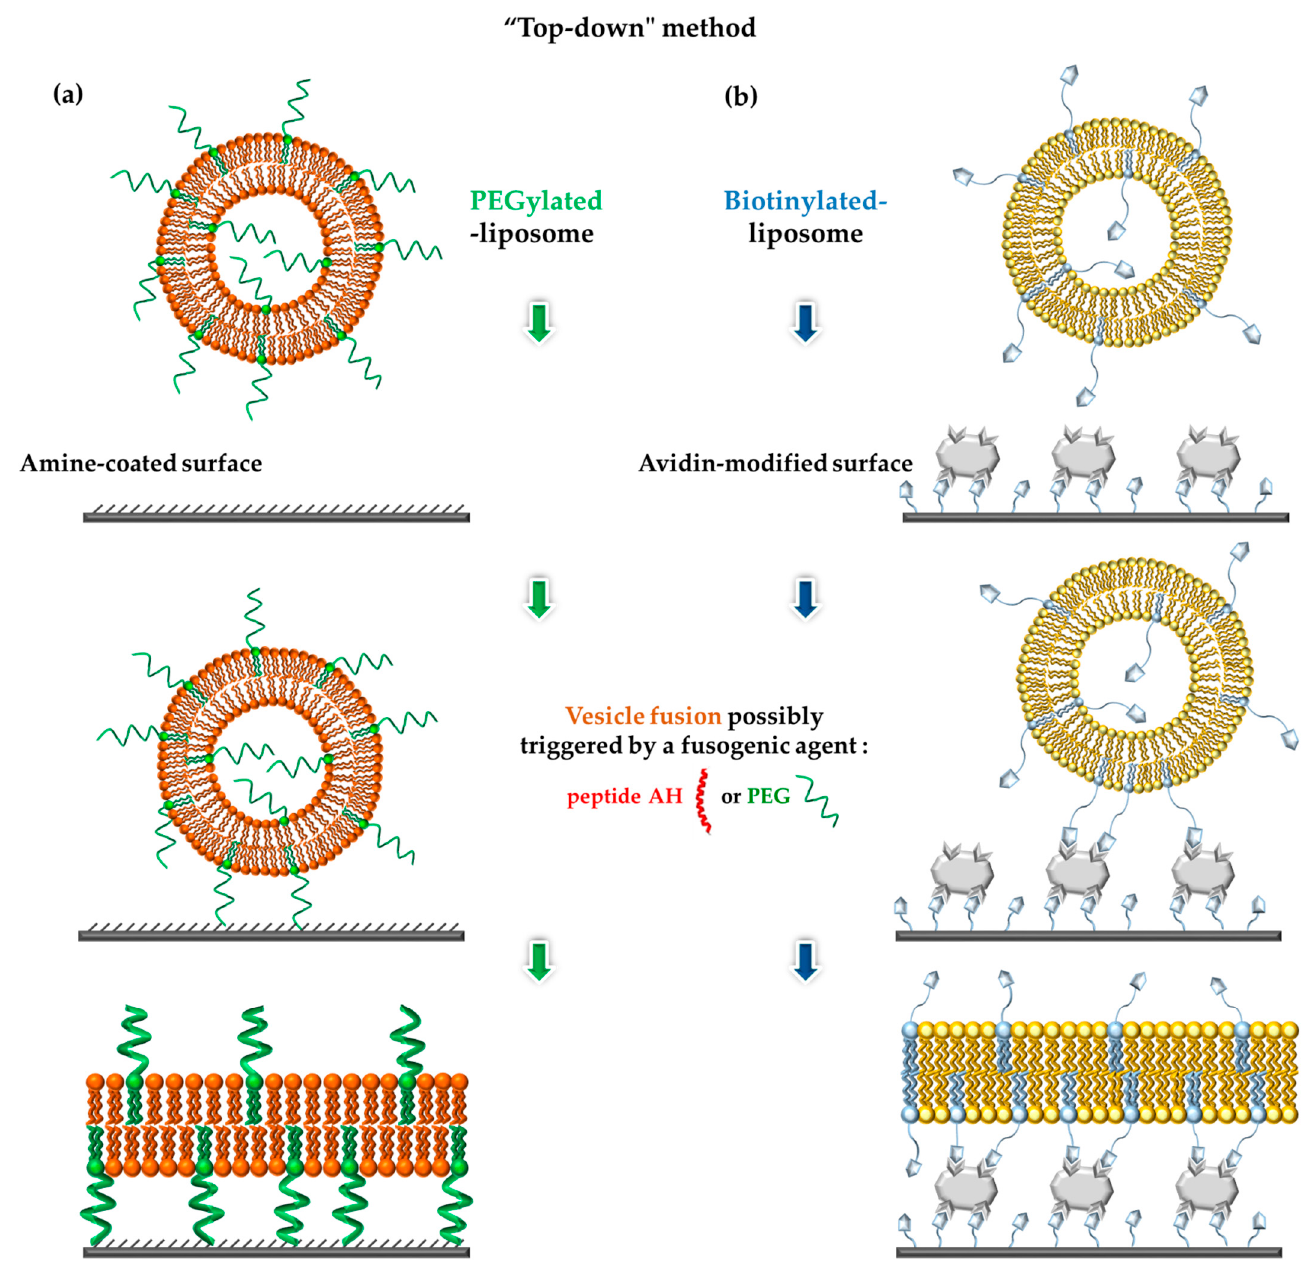
Figure 2. tBLMs formed by fusion of lipid vesicles containing both the anchor and the spacer molecules on a functionalized surface via a “top-down” approach. ( a ) using PEG as spacers, by fusion of liposomes containing either DSPE-PEG-NHS or DSPE-PEG-PDP on an amine-coated surface; ( b ) using biotin/avidine as spacers, by fusion of biotinylated vesicles on a sublayer of immobilized streptavidin. In both cases, the liposome fusion can be triggered by a fusogenic agent (i.e., PEG- 8000 solution [81,134,214,217] or an amphipathic α -helix (AH) peptide [39] ). DSPE-PEG-NHS: 1,2-distearoyl-sn-glycero- 3-phosphoethanolamine-poly-(ethyleneglycol)-N-hydroxysuccinimide; DSPE-PEG-PDP: 1,2-distearoyl-sn-glycero-3- phosphoethanolamine-N-poly(ethyleneglycol)-2000-N-[3-(2-pyridyldithio)propionate].